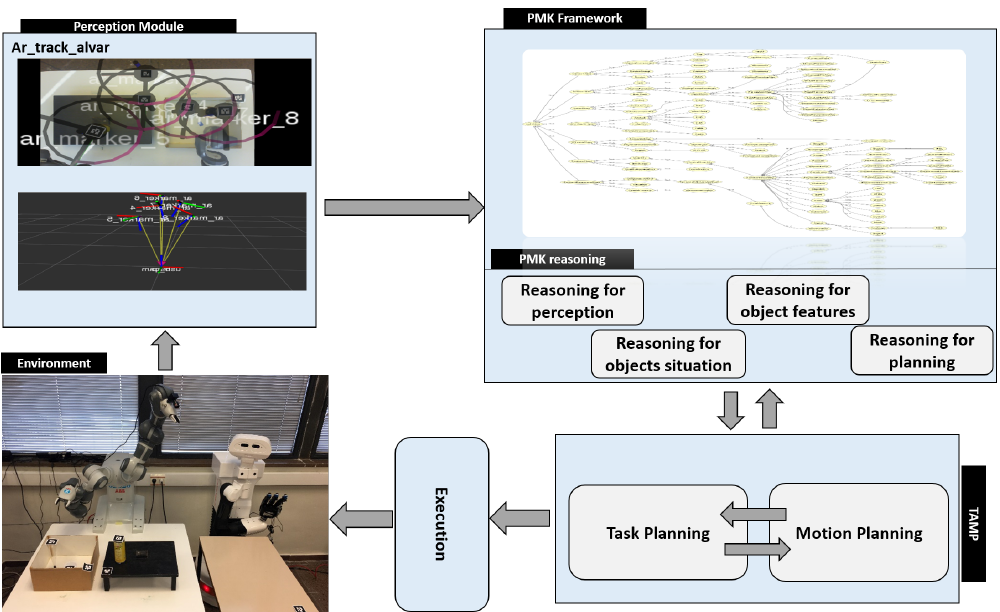
Figure 3. Main parts of the system: The perception module, the Perception and Manipulation Knowledge (PMK) framework, and the TAMP planning module. PMK asserts the perceptual data,